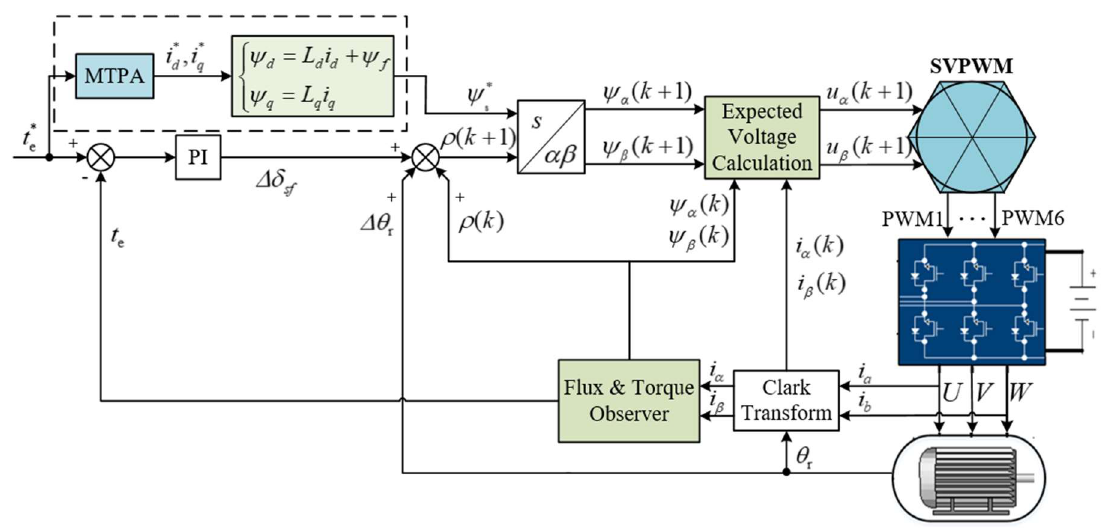
Figure 1. Block diagram of space vector pulse width modulation-direct torque control (SVPWM-DTC).